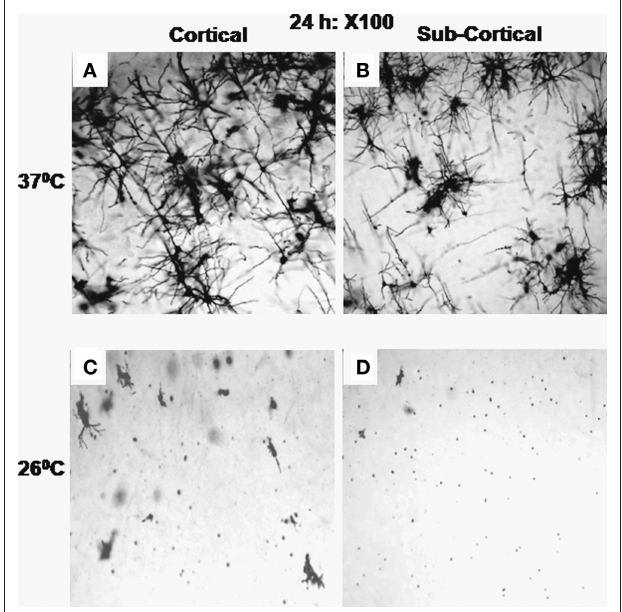
FIGure 5 | Stained neurons ( × 100) in sections through cortical (A and C) and sub-cortical (B and D) areas after incubation of the brain blocks for 24 h at 37 ± 1 ° C (A,B) and at 26 ± 1 ° C (C,D) are shown. All the sections showed completely filled neurons at the end of 24 h incubation at 37 ± 1 ° C; however, very few neurons can be seen after incubation at 26 ± 1 ° C.